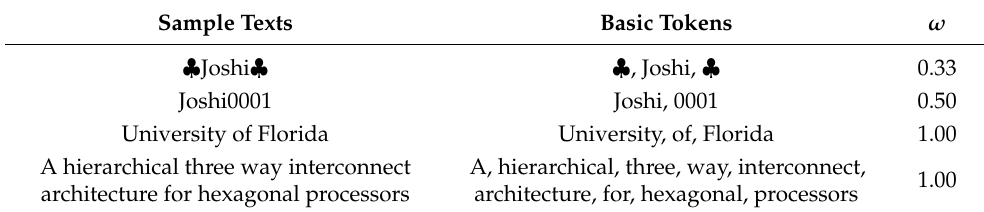
Table 1. Examples of the word granularity